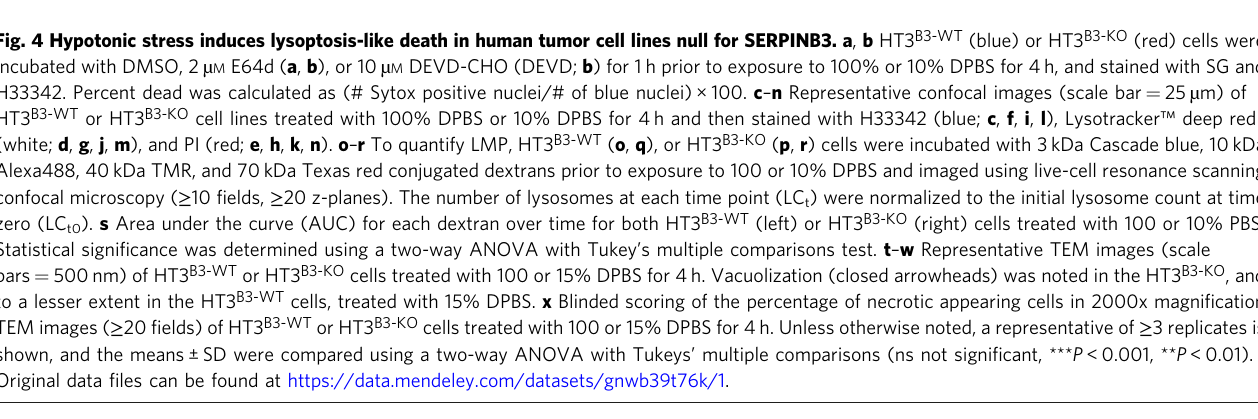
Fig. 4 Hypotonic stress induces lysoptosis-like death in human tumor cell lines null for SERPINB3. a , b HT3 B3-WT (blue) or HT3 B3-KO (red) cells were incubated with DMSO, 2 µ M E64d ( a , b ), or 10 µ M DEVD-CHO (DEVD; b ) for 1 h prior to exposure to 100% or 10% DPBS for 4 h, and stained with SG and H33342. Percent dead was calculated as (# Sytox positive nuclei/# of blue nuclei) × 100. c – n Representative confocal images (scale bar = 25 µ m) of HT3 B3-WT or HT3 B3-KO cell lines treated with 100% DPBS or 10% DPBS for 4 h and then stained with H33342 (blue; c , f , i , l ), Lysotracker ™ deep